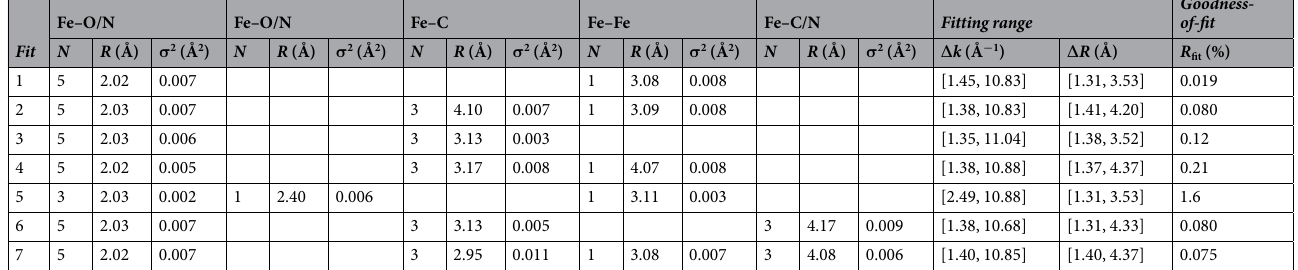
7 Scientific RepoRts | 7: 8369 | DOI:10.1038/s41598-017-08610-w